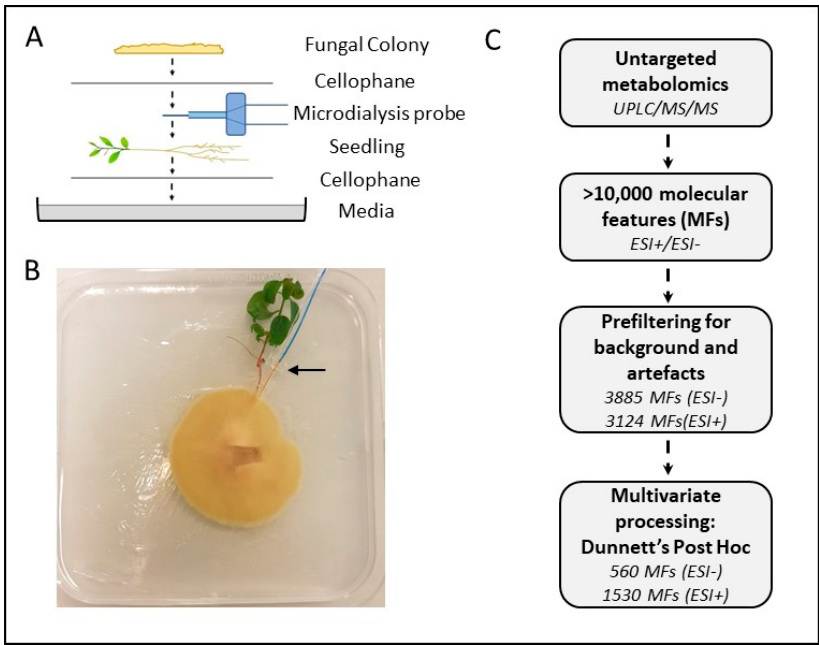
Figure 1. Experimental set-up and data flow for microdialysis-based analysis of metabolites. Schematic ( A ) and photograph ( B ) of experimental set-up for microdialysis probe-based sampling of secreted metabolites from the indirect contact between P. microcarpus (fungal colony) and E. grandis (seedling). Arrow indicates the location of the microdialysis probe. ( C ) Flow chart describing major steps in analysing and filtering the metabolomics data obtained from the 48-h time point samples for ESI- and ESI+ modes.